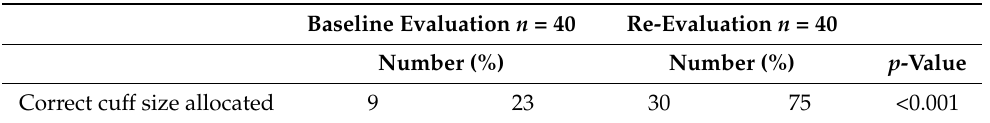
Table 3. The primary outcome: number and proportion of correct NIBP cuff size allocated before and after the intervention.